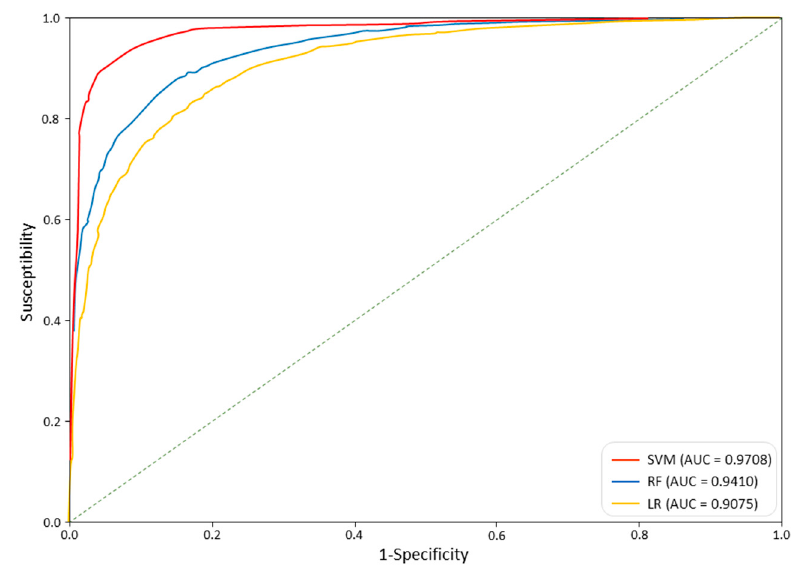
Figure 9. Comparison of the three models’ ROC curves and AUC values.